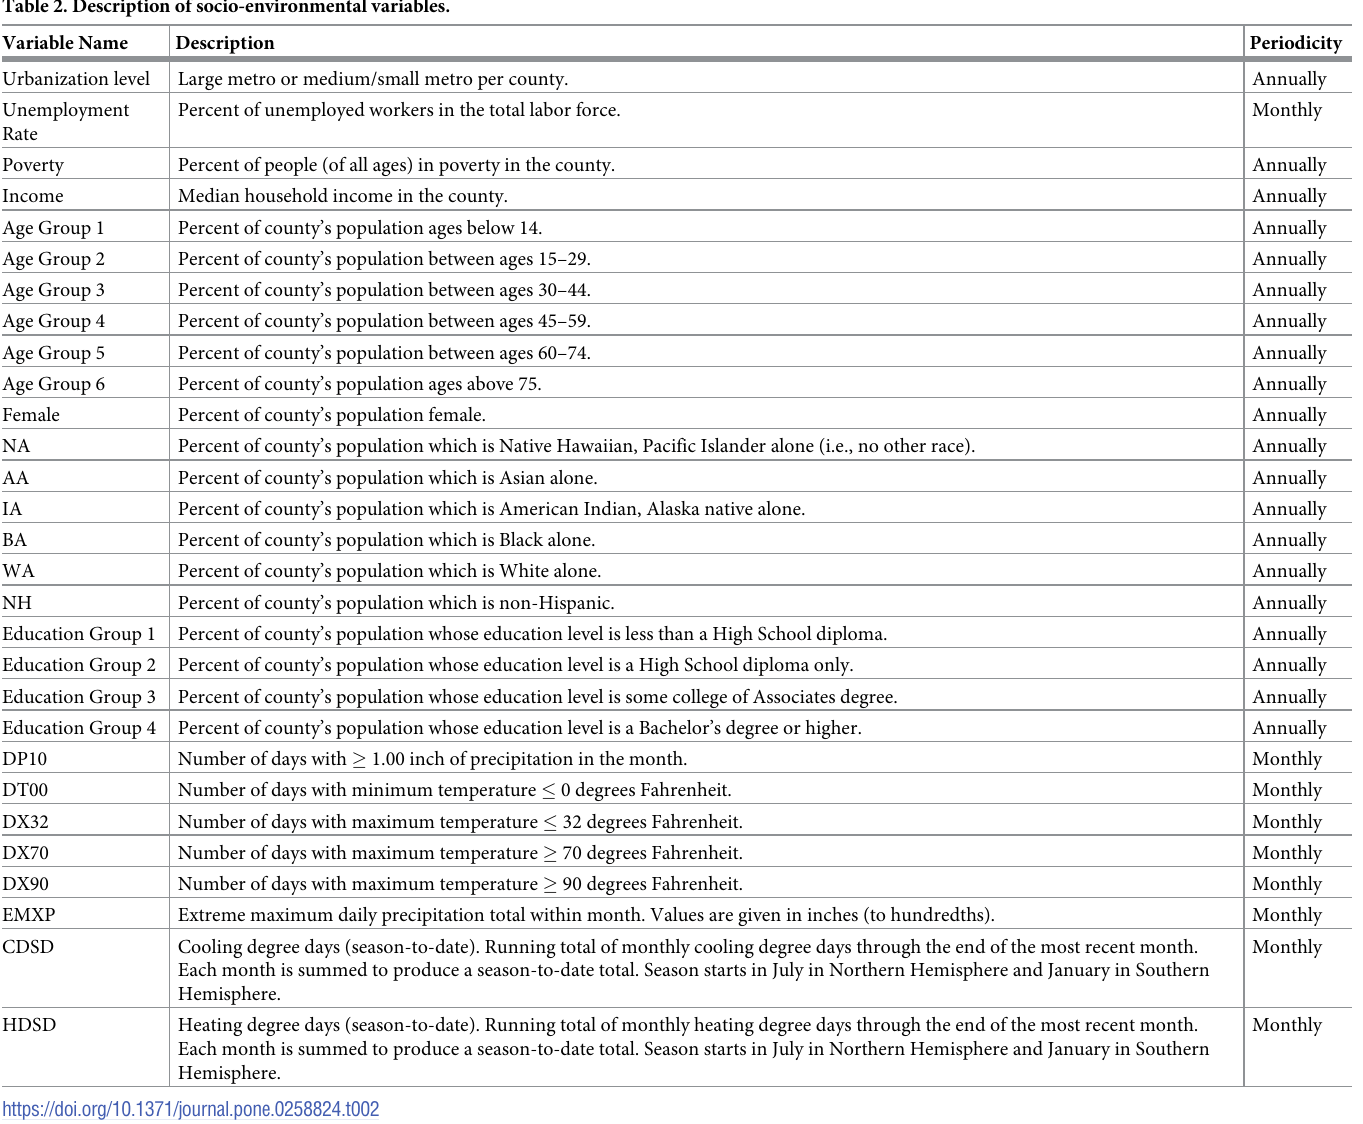
Table 2. Description of socio-environmental